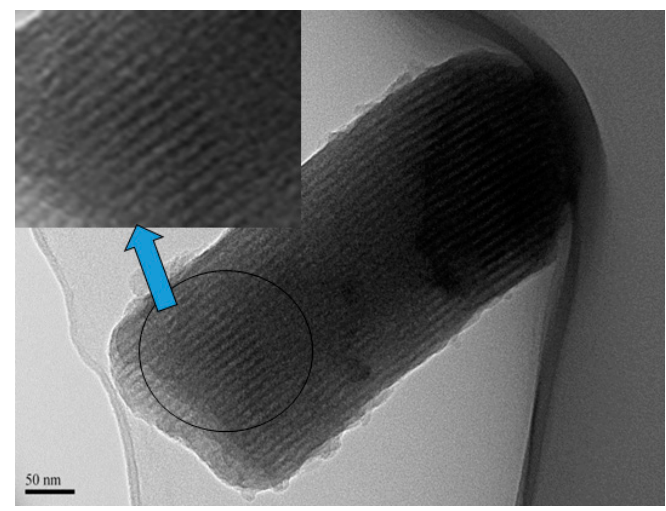
Figure 3. Transmission electron microscope (TEM) image of RSNMC.